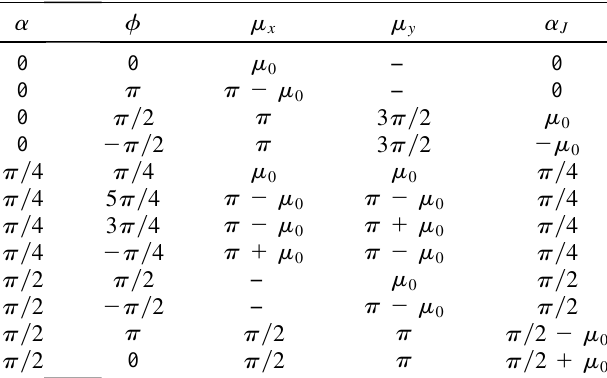
TABLE III. Secondary collimator locations m (cid:120) and m (cid:121) and jaw orientations a (cid:74) for three scattering azimuths a and